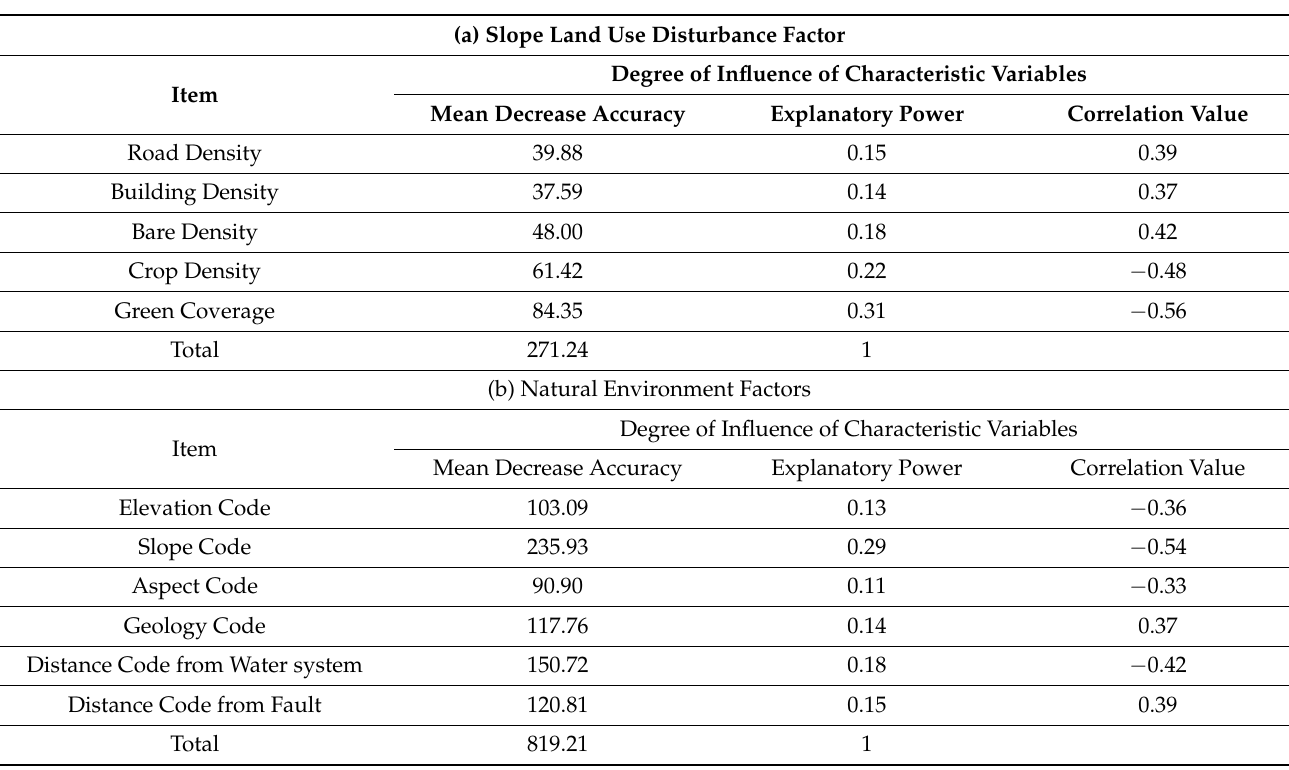
Table 2. Effects of the characteristic variables of slope land use disturbance factors and natural environmental factors.